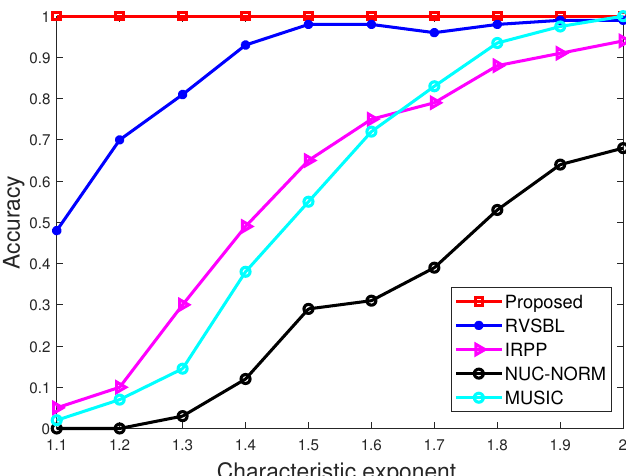
Figure 3. Accuracy with different characteristic